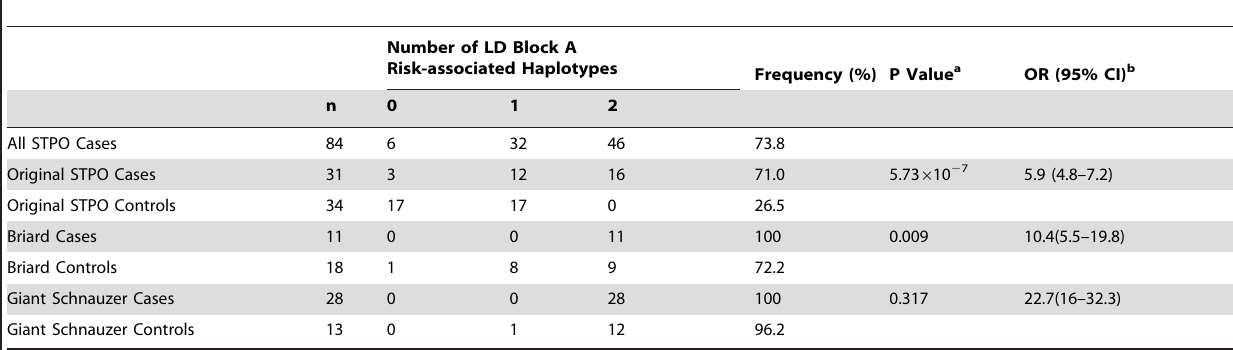
Table 2. Association between SCCD risk and the LD block A risk-associated haplotype in the STPO, Briard, and Giant Schnauzer cases and controls.